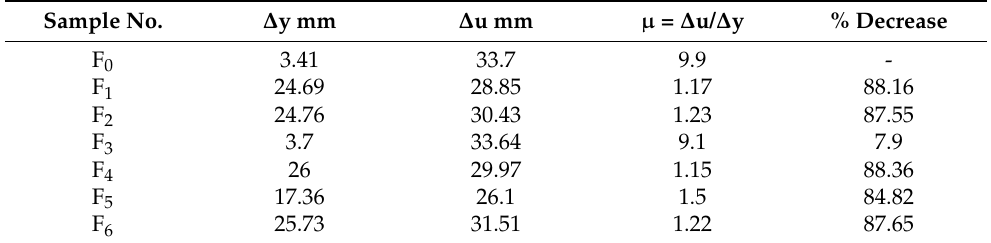
Table 4. Displacement ductility coefficient